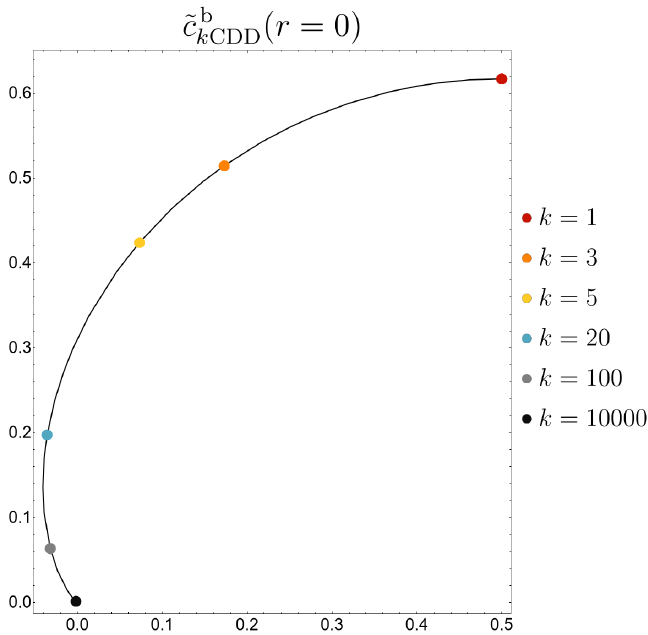
resonances in the theory, computed for the bosonic TBA with the constant solutions of figure 8 and Rogers’ dilogarithm formula (2.10). We show only one of the complex conjugate pairs for simplicity. The corresponding curve for fermionic theories is the same provided we map k → k + 1 . The first point k = 1 in red matches the bosonic sinh-Gordon model value, cf. figure 3. In the limit with infinite resonances k → ∞ the complex effective central charge goes to zero as we find in the elliptic sinh-Gordon models, see figures 5 and